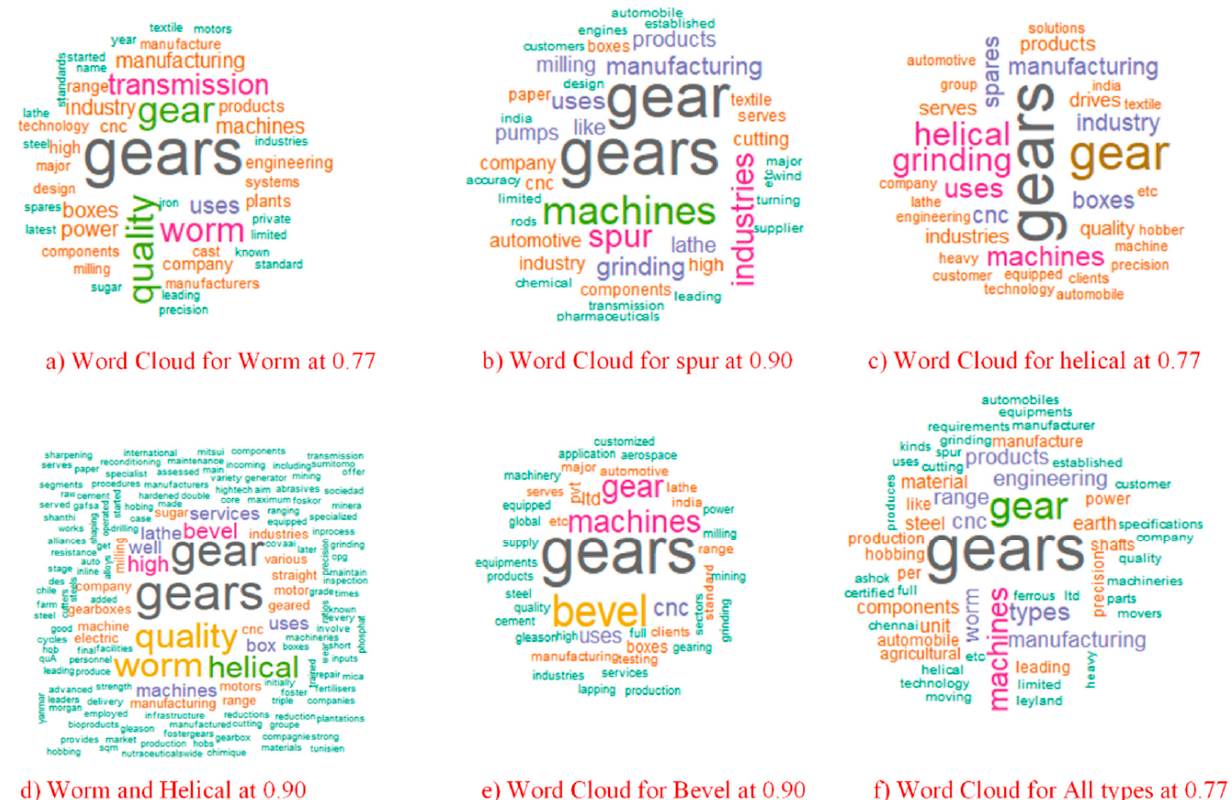
Figure 4. ( a ) Word Cloud for Worm at 0.77, ( b ) Word Cloud for Spur 0.90, ( c ) Word Cloud for Helical ( d ) Word Cloud for Worm and Helical at 0.90, ( e ) Word Cloud for Bevel at 0.90, and ( f ) Word Cloud for All Types of gears at 0.77 sparsity.